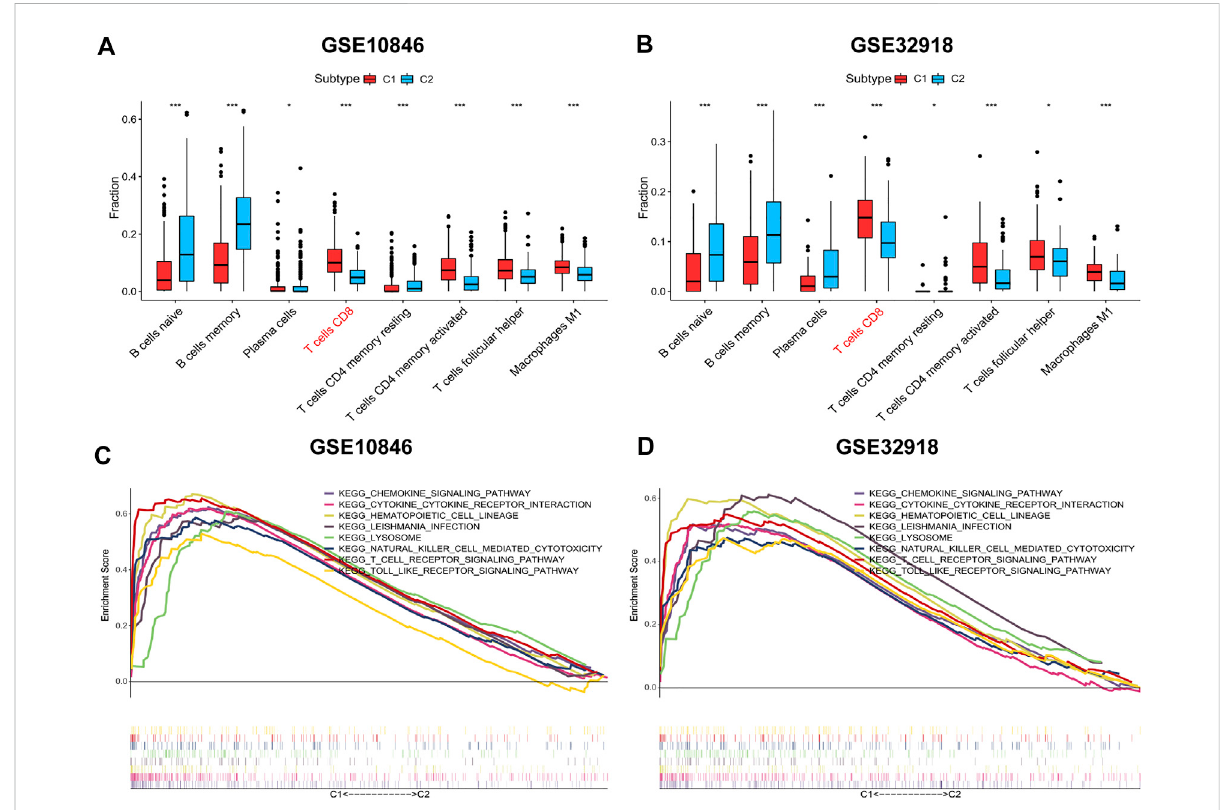
FIGURE 4 Distribution of immune cells and gene sets enrichment analysis (GSEA). (A-B) The distribution differences of immune cells between the subtypes based on CIBERSORT algorithm. (C-D) C1 vs. C2 GSEA. Wilcoxon test was used to compare immune cells of the two subtypes. * p < 0.05, ** p < 0.01, *** p <